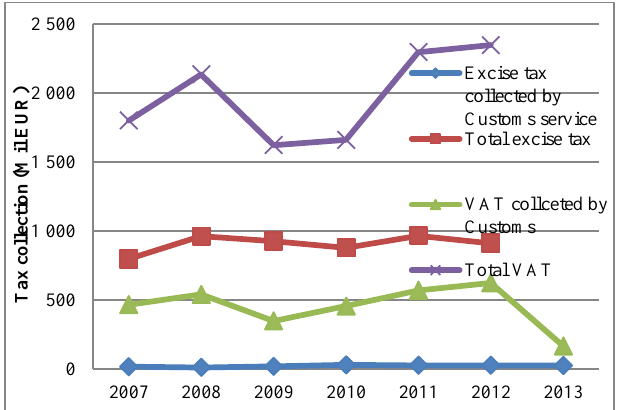
Fig. 4. VAT applied and excise tax collected by Customs Service of Lithuania. Source : Ministry of Finance of the Republic of Lithuania. Annual consolidated